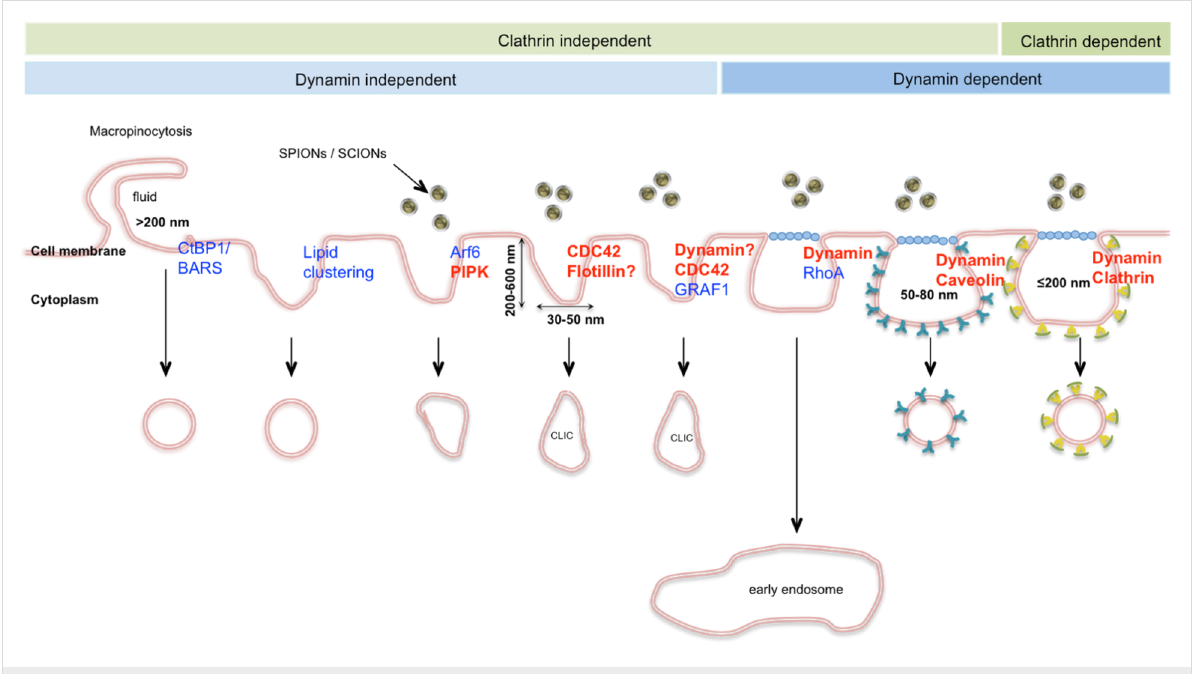
Figure 1: Overview of well-known endocytotic pathways and the involved key proteins, target proteins inhibited in this study are marked in red (adapted from Wieffer et al. [27], sizes of membrane ruffling from Canton et al.